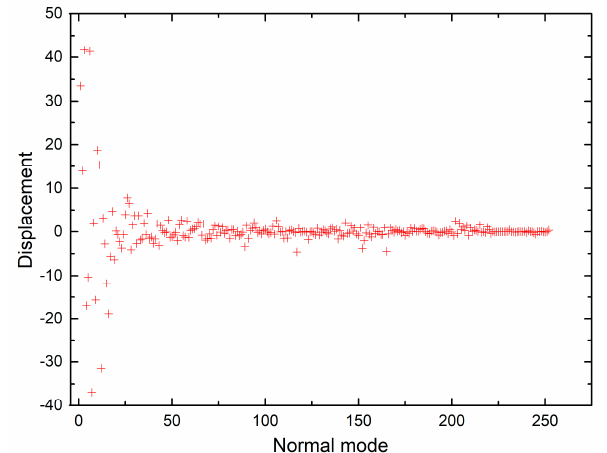
Molecules 2019 , 24 , x Figure 6. Shift vectors of chlorophyll a normal modes calculated using CAM-B3LYP functional, 6-31G(d) basis set.